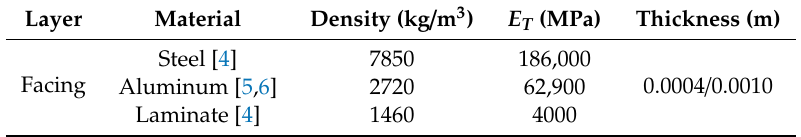
Table 2. Geometrical and mechanical properties of the sandwich panel facing materials.